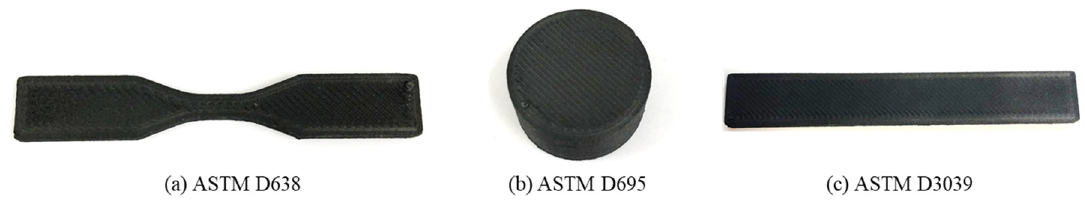
Figure11. Samplesprintedbytheoptimalparametersettingsfortheoverallmanufacturingperformance. Figure 11. Samples printed by the optimal parameter settings for the overall manufacturing ( a ) ASTM D638; ( b ) ASTM D695; ( c ) ASTM performance. ( a ) ASTM D638; ( b ) ASTM D695; ( c ) ASTM D3039.